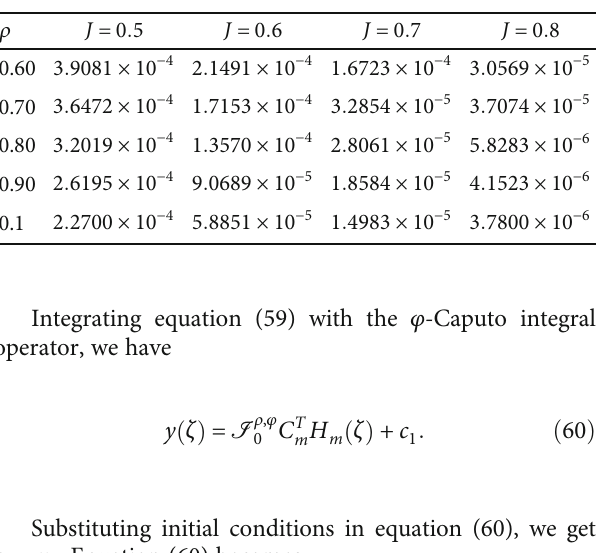
Figure 4: Approximate solutions for ρ = 1 , J = 5 , and di ff erent choices of φ ð ζ Þ . Table 5: Maximum absolute error for various choices of ρ and J